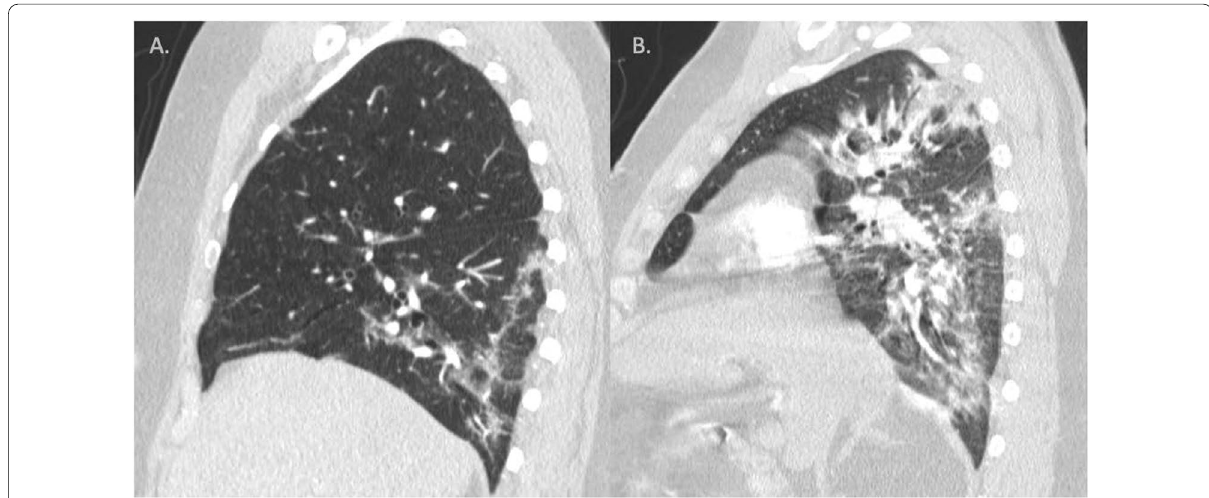
Fig. 2 Representative images demonstrating the difference between a CT-SS scoring system. A Severity score scoring system